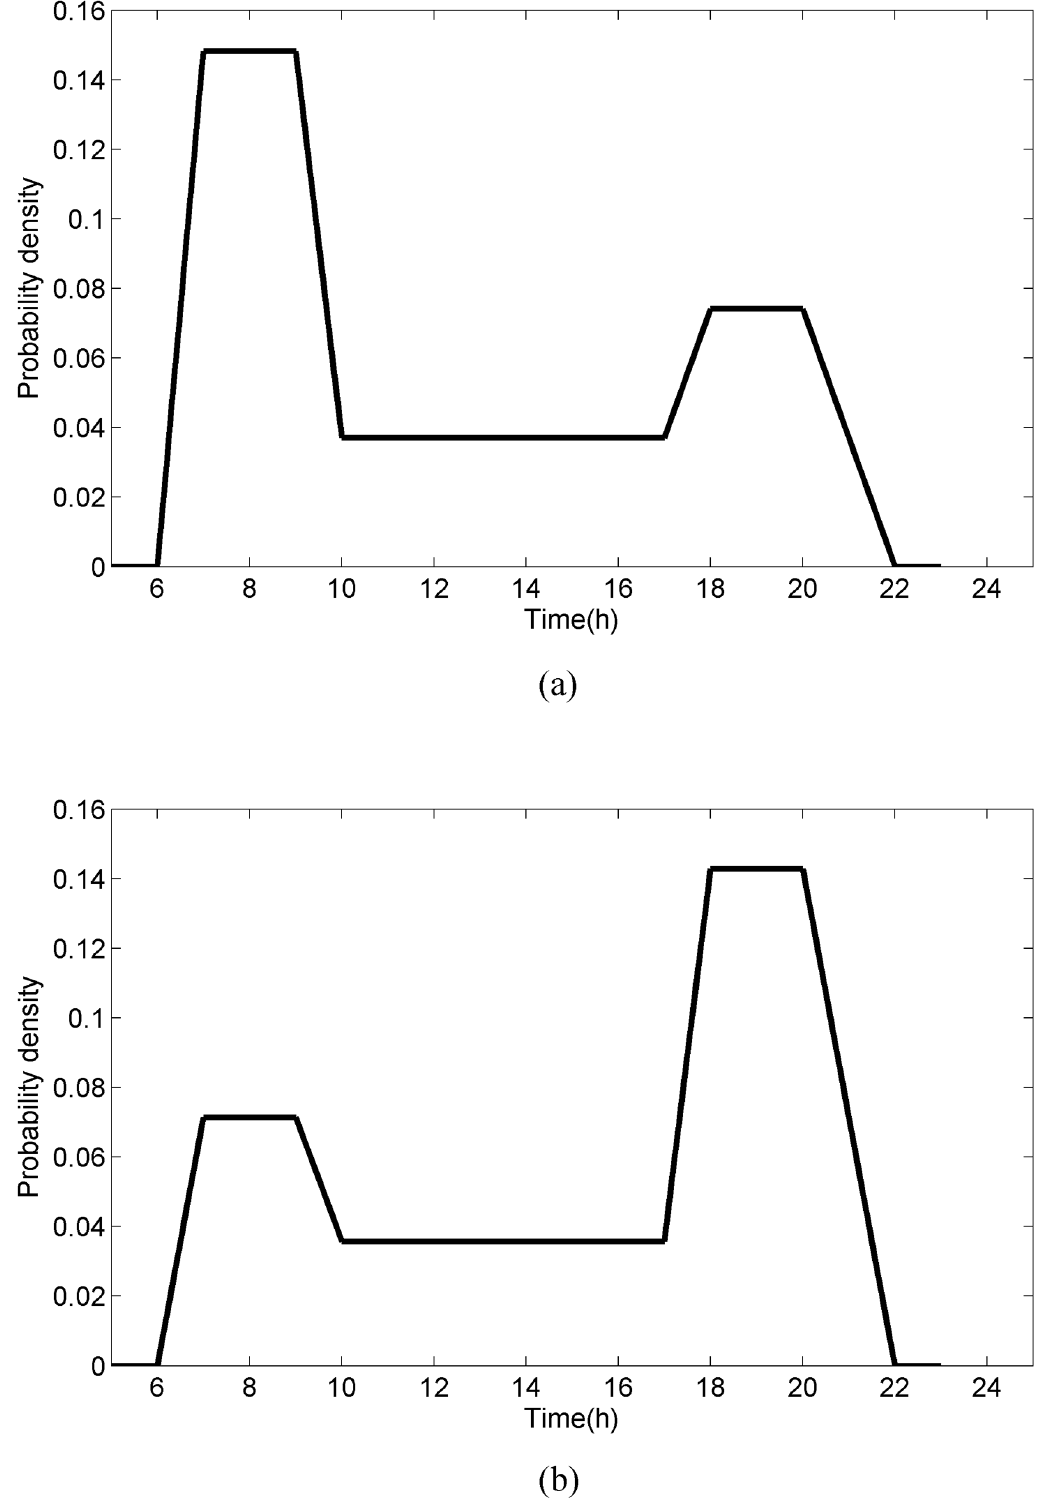
Fig 5. Two classesof density distributions of